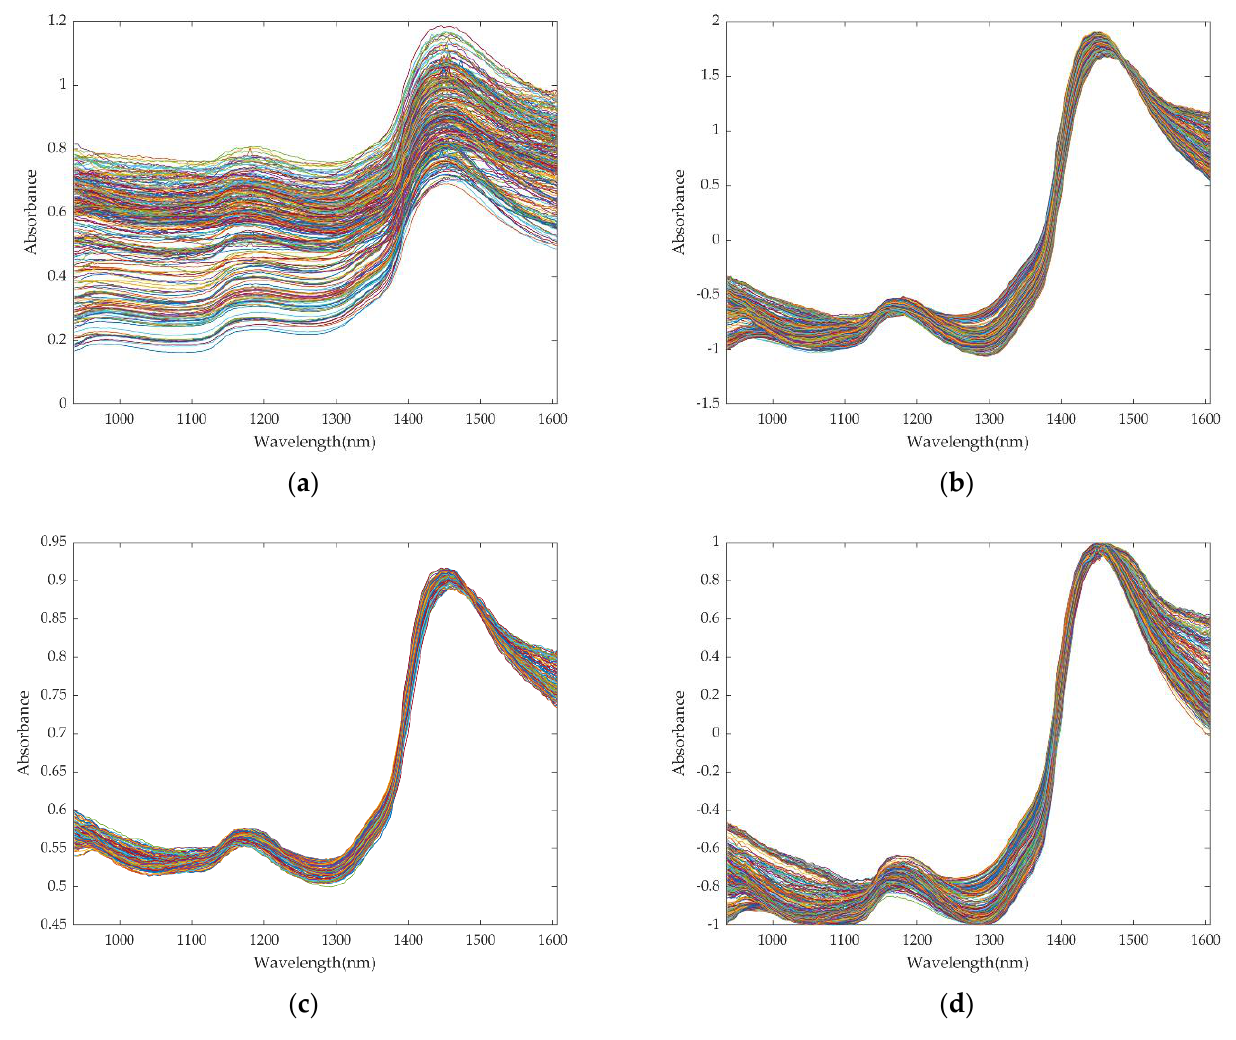
Figure 7. NIR and various preprocessed spectra: ( a ) raw NIR, ( b ) NIR using SNV, ( c ) NIR using MSC, and ( d ) NIR using max – min.